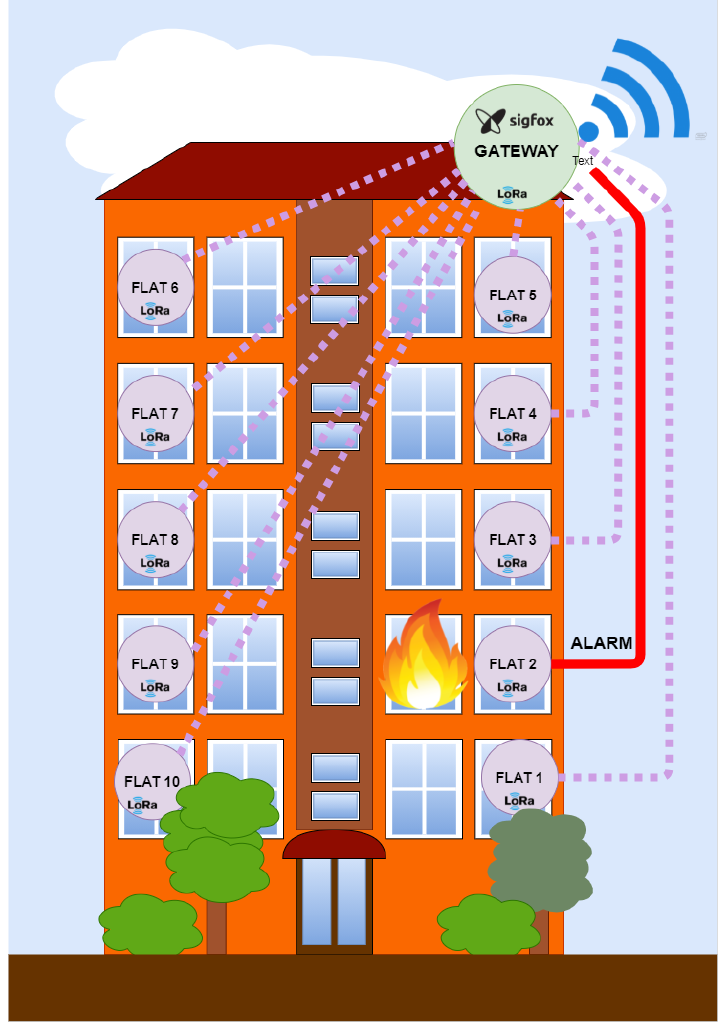
Figure 4. Layer 2: Star LoRa RAW Network